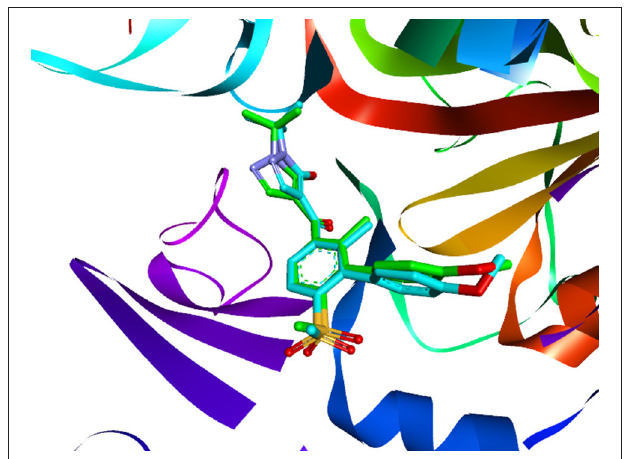
FIGURE 8 | The ligand compared by the CDOCKER docking method. Redocked ligand was green and the native ligand in the crystallographic complex was